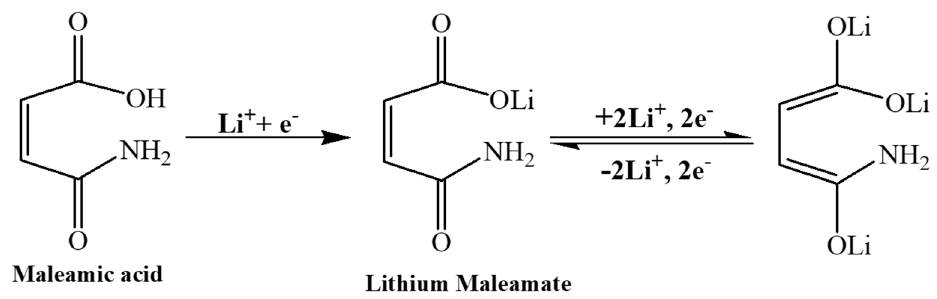
Scheme 1. The representative of the lithium-ion storage mechanism on the MA